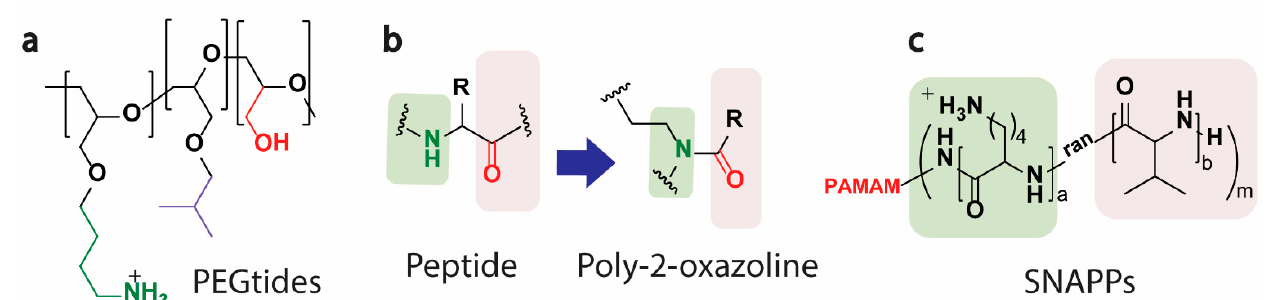
Figure 6. Examples of newly reported polymer mimics of HDPs. ( a ) mimicking amino acid residues on the backbone of the PEG chain and developing PEGtides, ( b ) glycine-like backbone substituent poly-2-oxazoline, ( c ) a new class of antimicrobial nanomaterials referred to as structurally nanoengineered antimicrobial peptide polymers (SNAPPs).